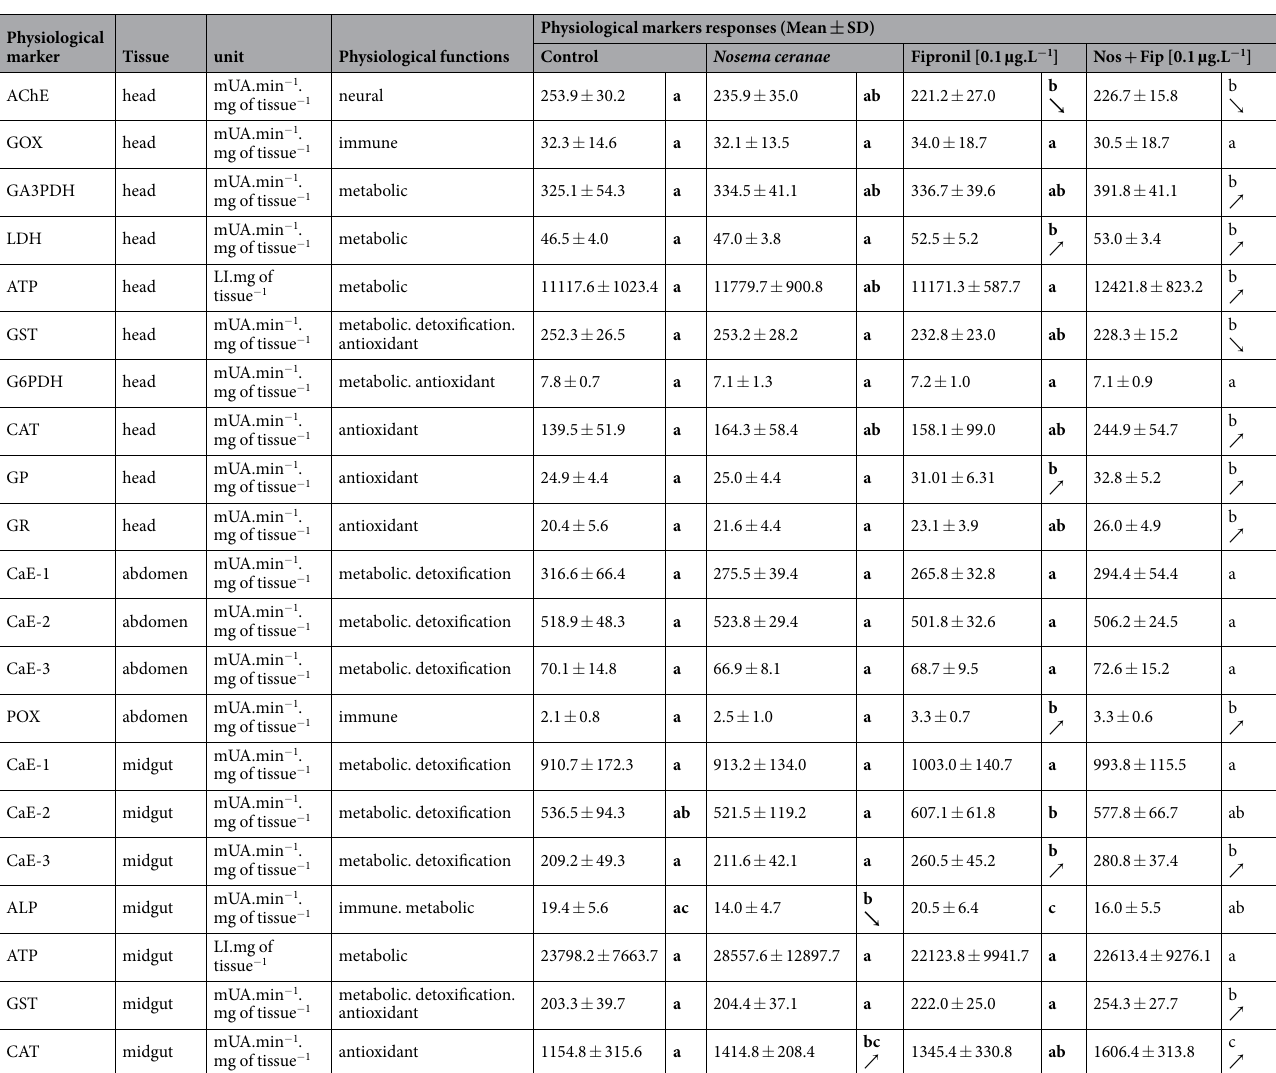
Table 1. Effects of the stressors, alone or combined, on physiological markers in drones. A multiple markers approach was performed to study the effects of the stressors in the head, midgut and abdomen of drones. Each marker was associated with one or more of the main physiological functions (neural, metabolic, immune, detoxification and antioxidant). The data represent the mean values ± standard deviations of the physiological markers responses expressed in milliUnits of Absorbance (mUA) or in Luminescence Intensity (LI) for ATP. Three samples of 6 drones were measured from each hive (n = 12 for each modality of treatment). For statistical analyses, a generalized linear mixed model was applied considering a random effect of the hives from which the drones came. Significant differences at P ≤ 0.05 between modalities are expressed with different letters. Case with the same letters indicate no significant difference between the groups. Arrows indicate the direction of the modulation relative to the control